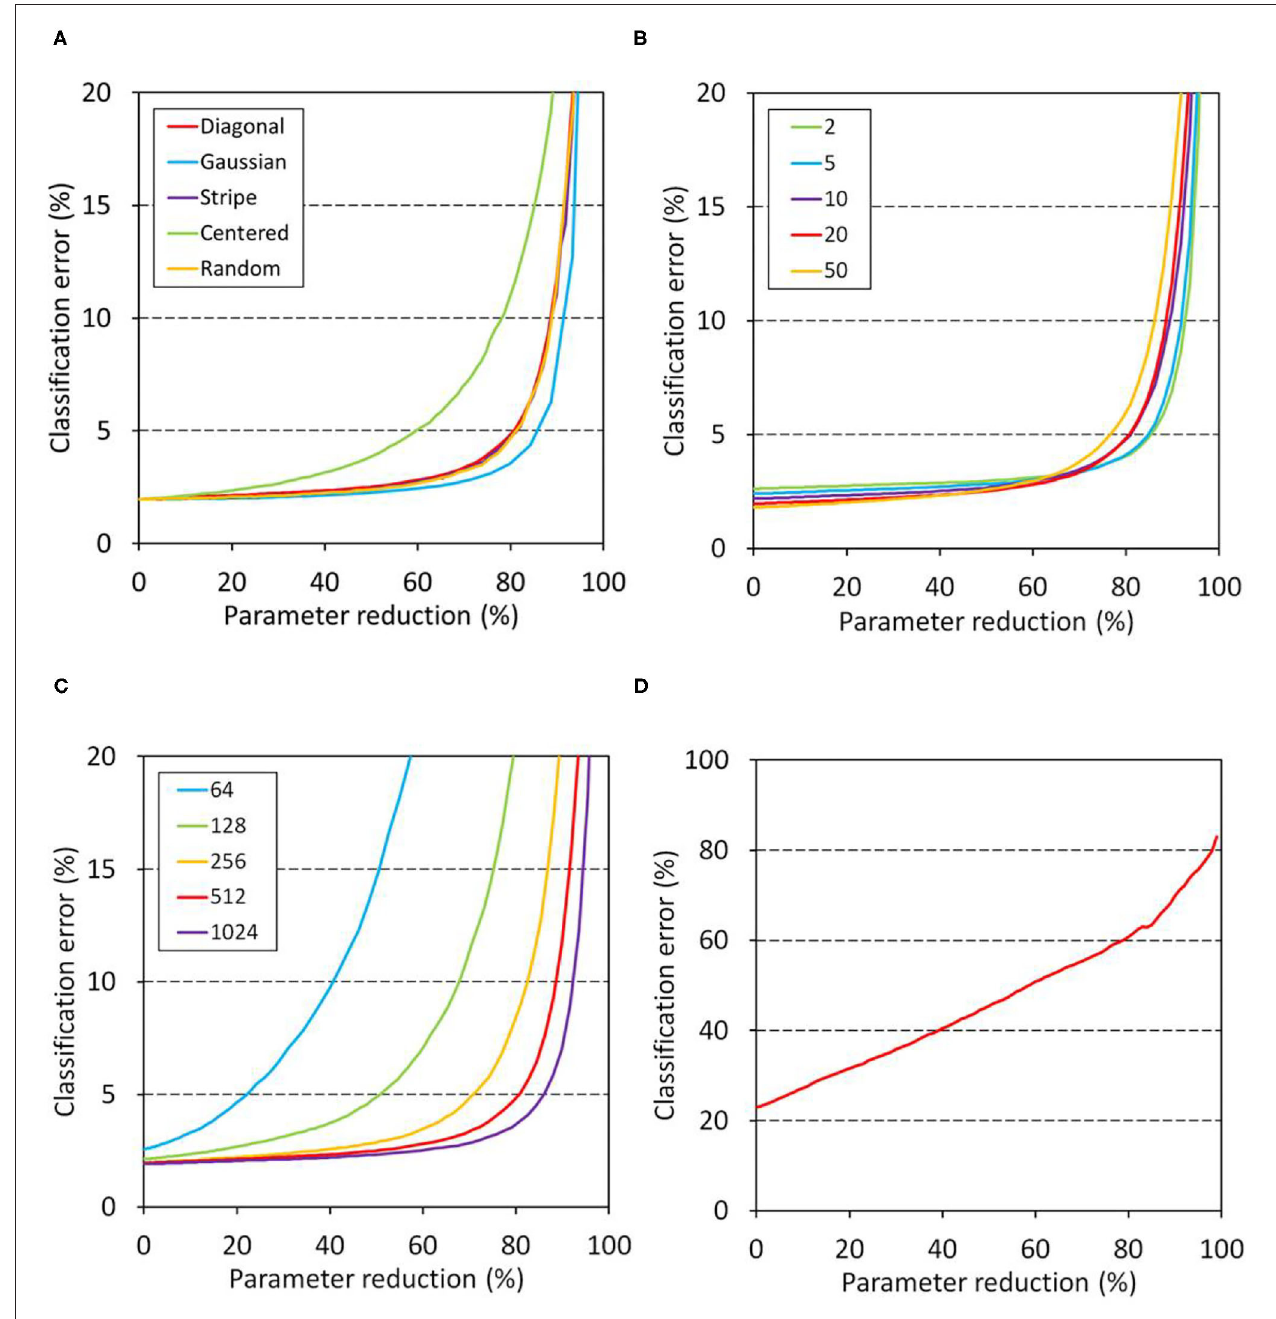
FIGURE 3 | Relationship between classification error and parameter reduction in the disorganized model. Networks were trained first and then the weights of the target layers were masked with a window in the evaluation. The left intercept corresponds to a network with fully connected layers. (A–C) Show the results of MNIST classification. Unless otherwise stated, network B ( Table 1 ) having 512 nodes in the two hidden layers was trained for 20 epochs and then its schizophrenia connection layer was masked using a diagonal window in the evaluation. The training and evaluation were repeated for 100 sessions and their mean errors were plotted. (A) Effect of window shape. (B) Dependence on training duration. (C) Dependence on hidden layer dimensions. (D) Results of CIFAR-10 classification. Network D ( Table 1 ) was trained for 100 epochs, and its top layer was masked using a diagonal window. The training and evaluation were repeated for 30 sessions, and their mean errors are